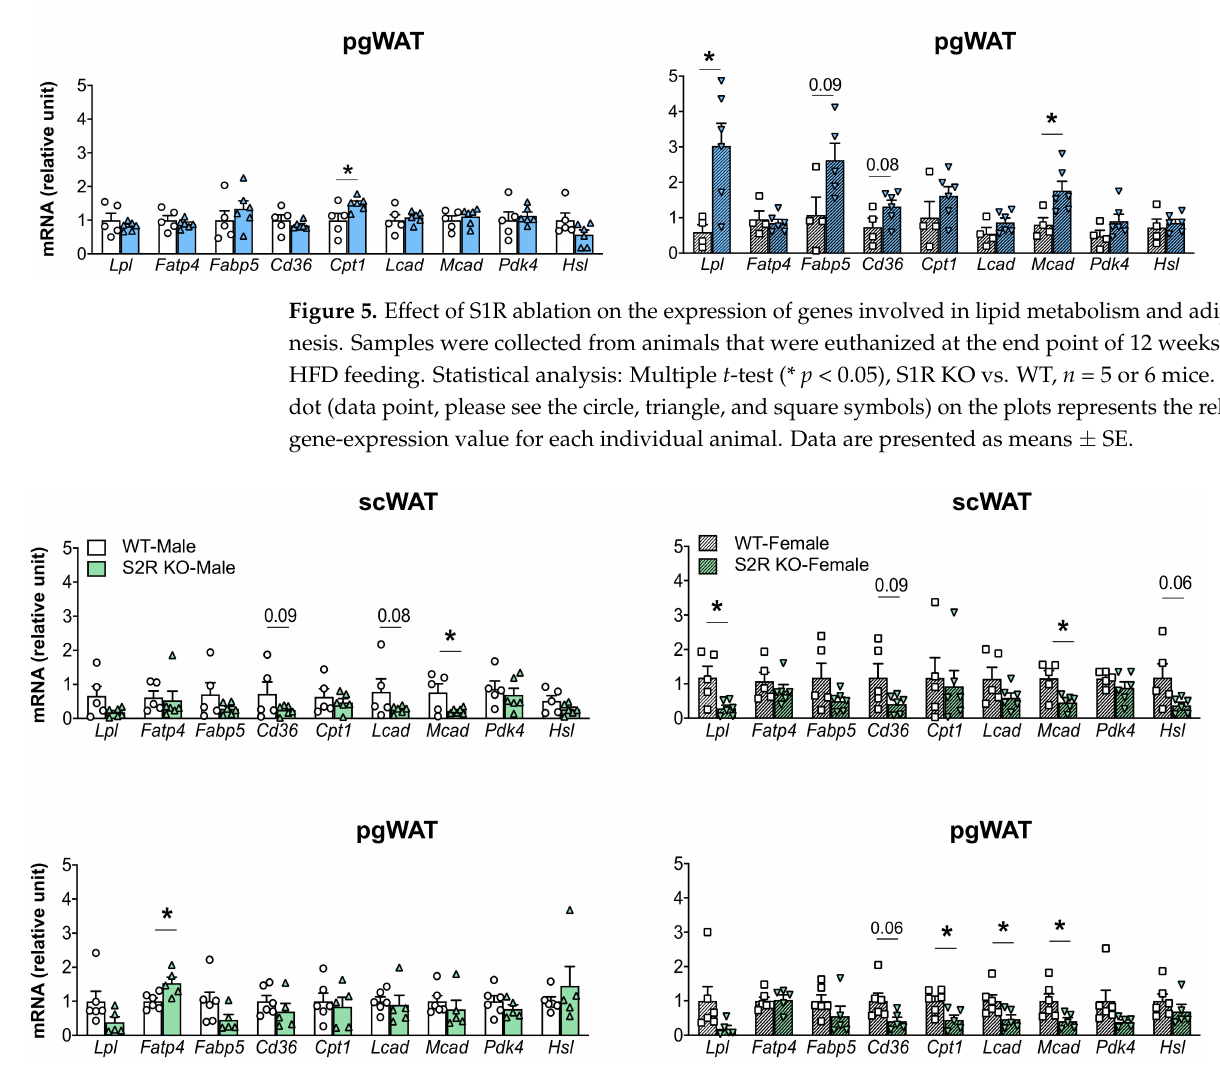
Figure 6. Effect of S2R ablation on the expression of genes involved in lipid metabolism and adipoge- nesis. Samples were collected from animals that were euthanized at the end point of 13 weeks after HFD feeding. Statistical analysis: Multiple t -test (* p < 0.05), S2R KO vs. WT, n = 5 or 6 mice. Each dot (data point, please see the circle, triangle, and square symbols) on the plots represents the relative gene-expression value for each individual animal. Data are presented as means ±